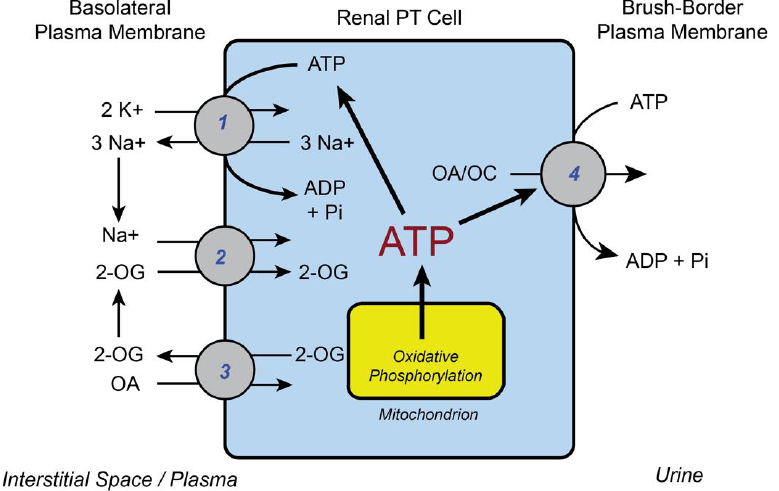
Figure 1. Generalized scheme showing coupling of various active transport processes in the renal proximal tubular (PT) cell to ATP levels and mitochondrial function. 1: (Na + + K + )-stimulated ATPase; 2: sodium-dicarboxylate 3 cotransporter (NaC3; Slc13a3); 3: organic anion transporter 1 or 3 (Oat 1/3; Slc22a6/8 ); and 4: multidrug resistance-associated protein 2 or 4 (Mrp2/4; Abcc2/4 ) or P-glycoprotein (Mdr1; Abcb1 ). Abbreviations: OA: organic anion; OC: organic cation; 2-OG: 2-oxoglutarate; Pi: inorganic phosphate.